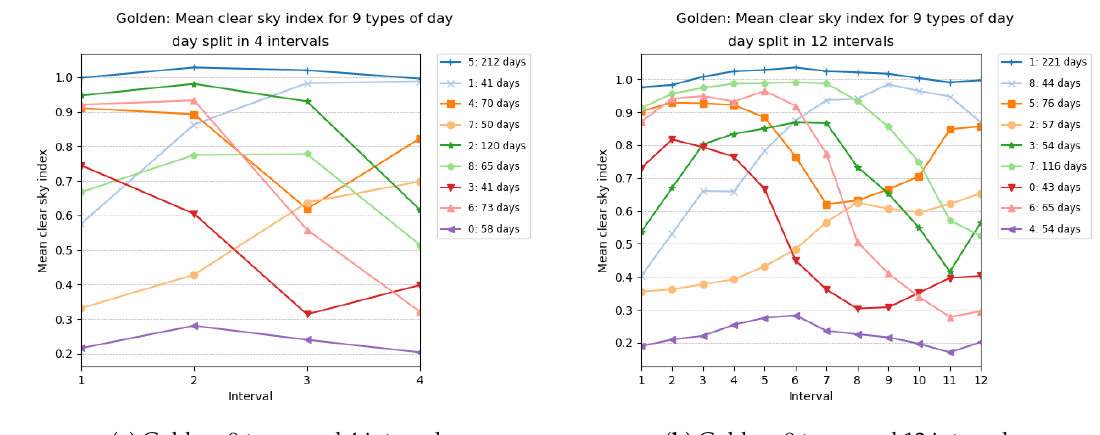
Figure 5. Types of days for Golden.